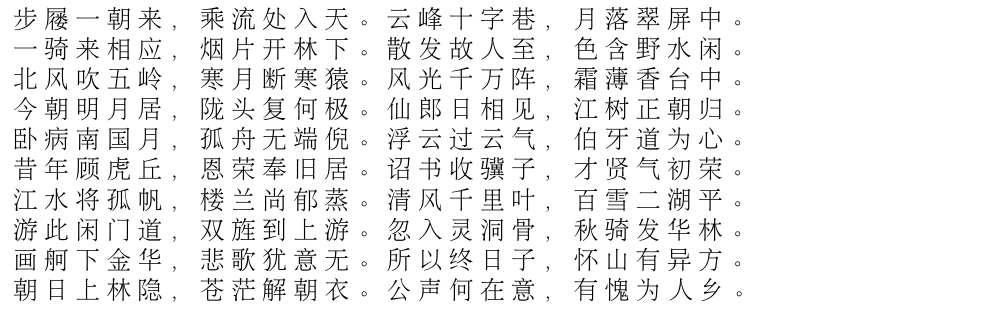
Table A3. The data samples generated from the Chinese poetry dataset.